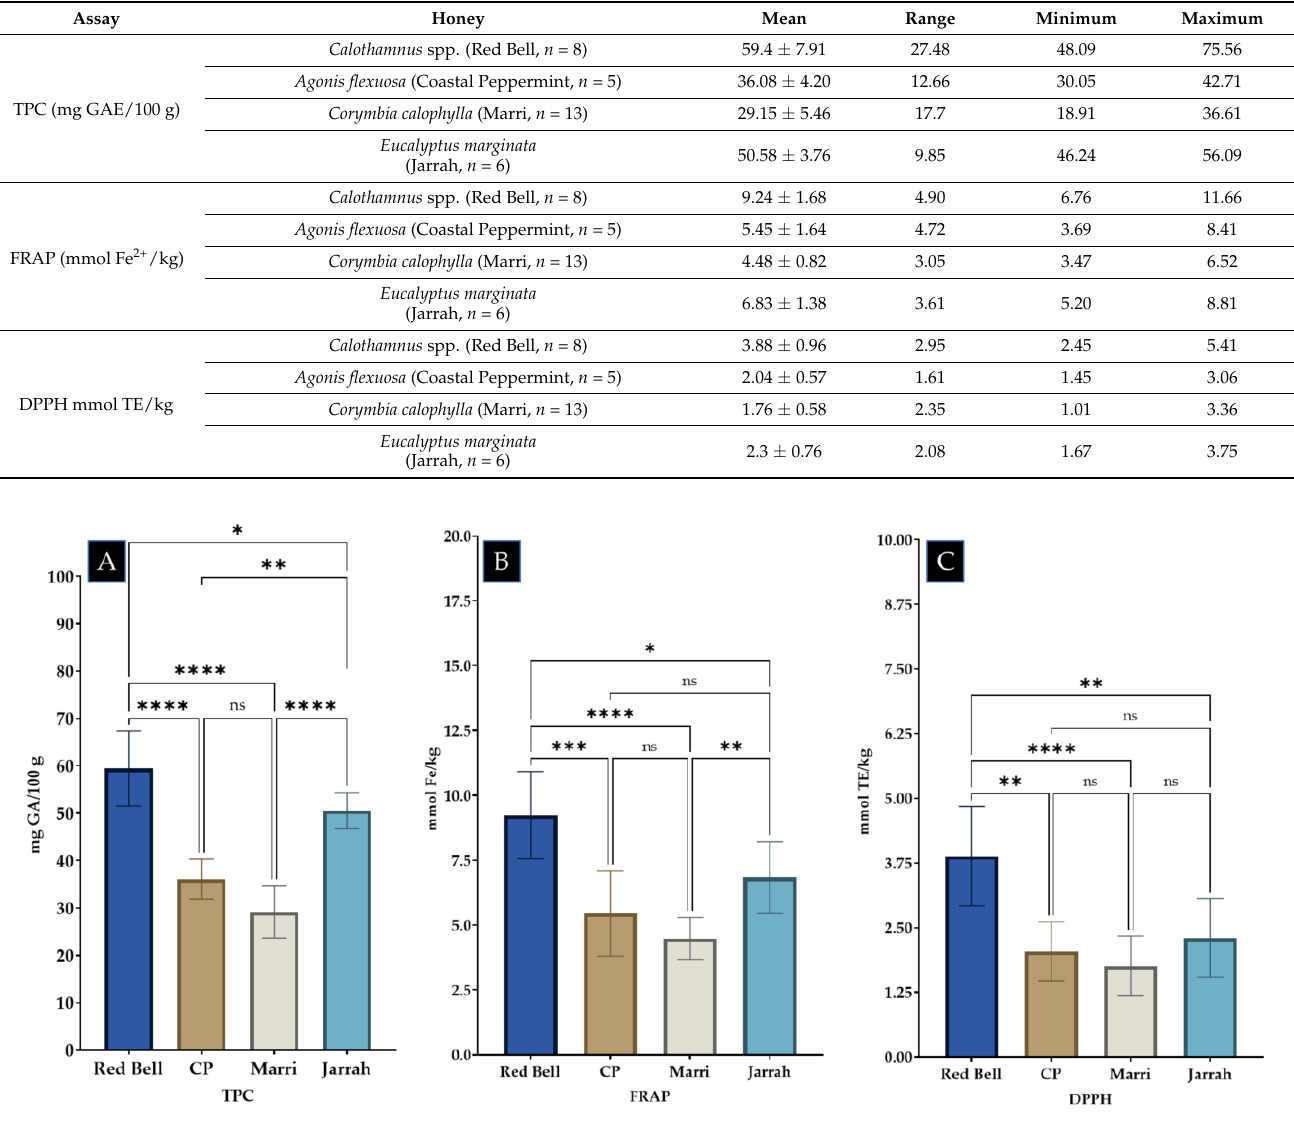
Figure 2. Comparison of the TPC ( A ), FRAP ( B ), and DPPH ( C ) of Calothamnus spp. (Red Bell), Agonis flexuosa (Coastal Peppermint, CP), Corymbia calophylla (Marri), and Eucalyptus marginata (Jarrah) honey. (Tukey post-hoc comparison: ns (not significant) = p > 0.05, * = p < 0.05, ** = p < 0.005), *** = p < 0.0005), **** = p < 0.0001).